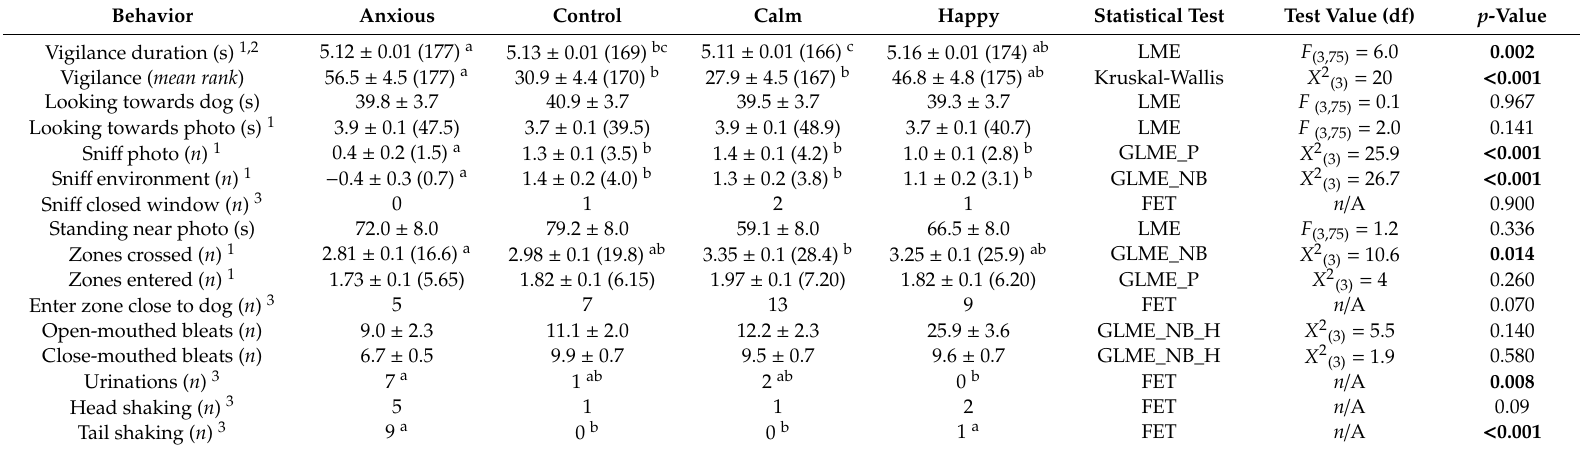
Table 2. Mean ± s.e.m. behavioral responses of sheep during the attention bias